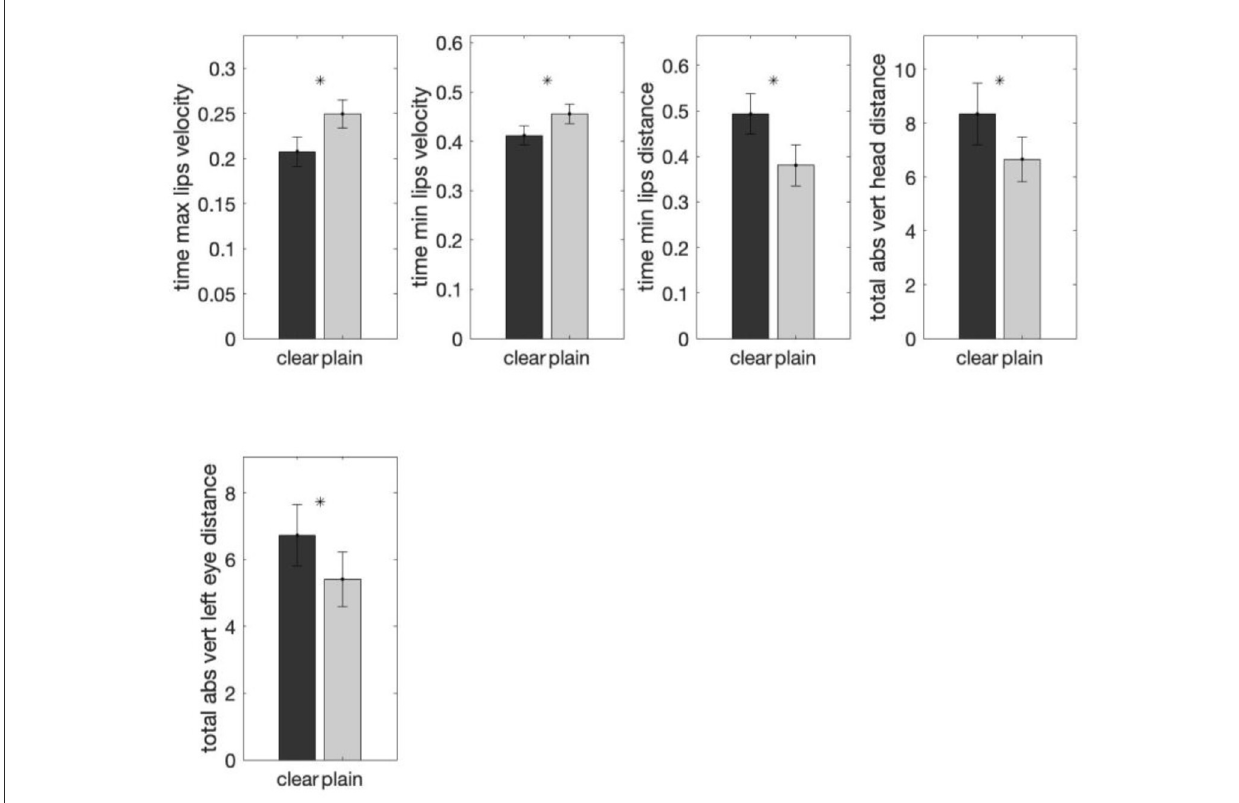
FIGURE7 Comparisons of the group means of each of the five important features (determined by random forest analyses) in clear and plain style in Tone 2. The y-axis shows the average normalized feature value for that particular style group. All features were found to exhibit a statistically significant difference between the two speech styles by mixed-effects modeling. The error bar on each of the bar plots shows the standard error. A * above a bar represents a p-value smaller than 0.05.